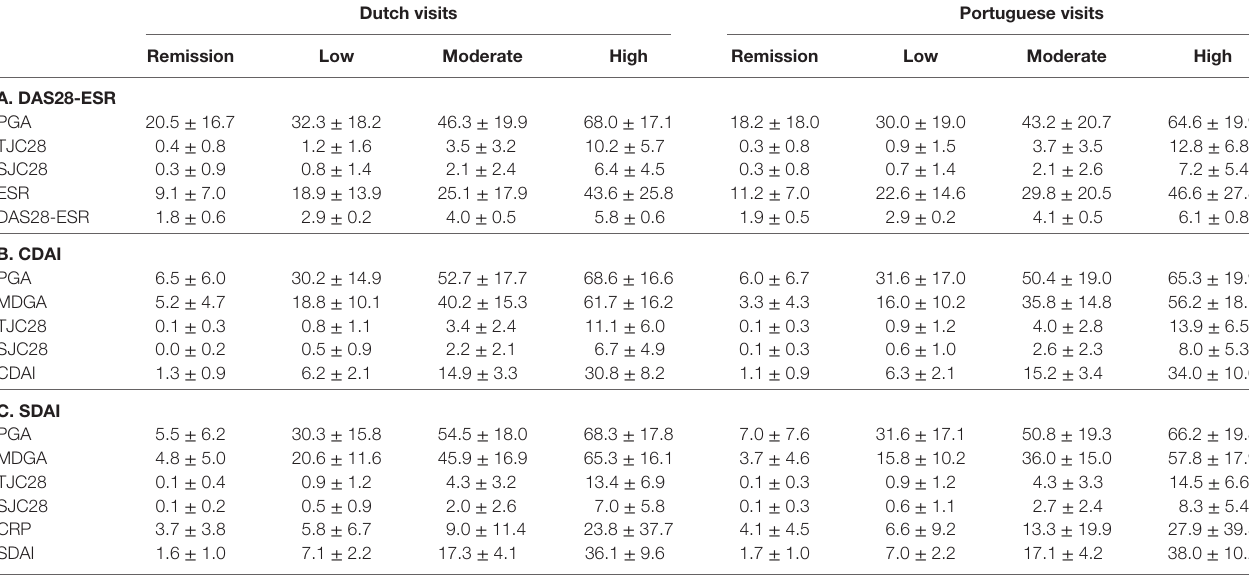
TaBle 4 | The mean scores for the individual components of each disease activity evaluation, according to disease activity category. Dutch visits Portuguese visits